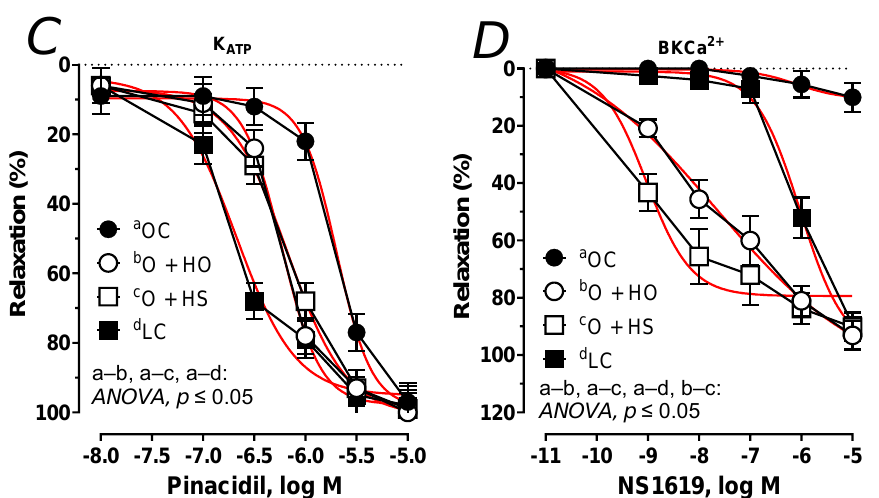
Figure 9. The relaxant response to acetylcholine ( A ), sodium nitroprusside ( B ), the K ATP channel opener, pinacidil ( C ), and the BKCa 2+ channel opener, NS1619 ( D ) of isolated thoracic arteries from 8-week-old lean (LC) and obese (OC) Zucker rats fed a diet containing hemp seed oil (HO) and hemp seeds (HS) for 4 weeks. Results (means ± SEM) are expressed as a percentage of the inhibition of the contraction induced by noradrenaline (0.1 µ M), n = 6, p ≤ 0.05 (two-way ANOVA/Sidak’s). HO and HS improved functioning of potassium channels dependent on ATP and Ca 2+ . Moreover, HS improved the impaired vascular relaxation to acetylcholine.